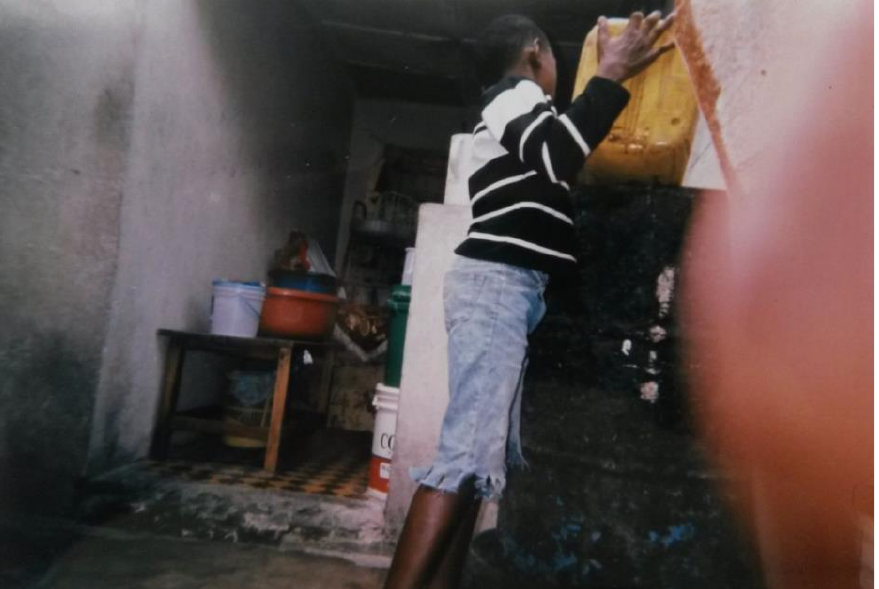
Figure 10. ‘This picture shows the hard work children do. A small child fetches water with a canister that is not their size. He should first reach the age when he can carry this much water. For now this amount is too big ’ . (Kulthum, 14 years